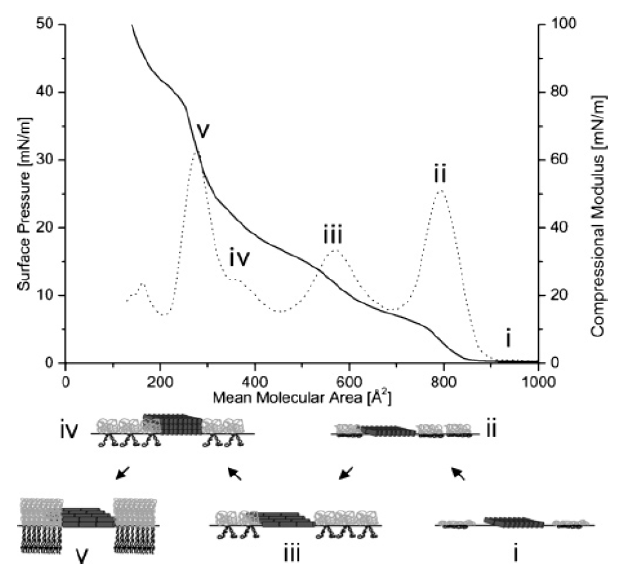
Figure 6. Monolayer organization using alamethicin -A pressure-area isotherm (solid line), compressional modulus (dotted line) of a 0.7:0.3 alm-polymer mixture, and a schematic drawing of molecular packing at the air-water interface